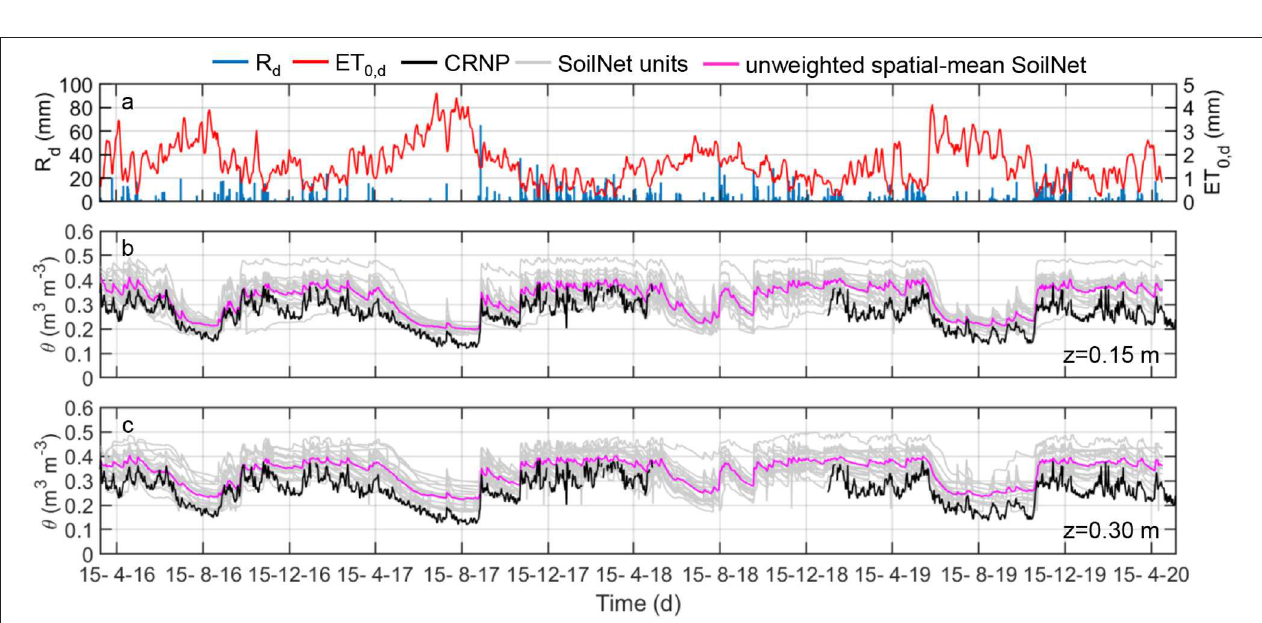
FIGURE 4 | Daily values of (a) rainfall, R d (blue bars), reference potential evapotranspiration, ET 0, d (red line), (b) SoilNet-based soil moisture contents (gray lines) at 0.15m soil depth at the 20 locations and their unweighted spatial-mean (blue line) and CRNP-based soil moisture (black line) and (c) SoilNet-based soil moisture contents (gray lines) at 0.30m soil depth at the 20 locations and their unweighted spatial-mean (blue line) and CRNP-based soil moisture (black line) at GOR1 site.